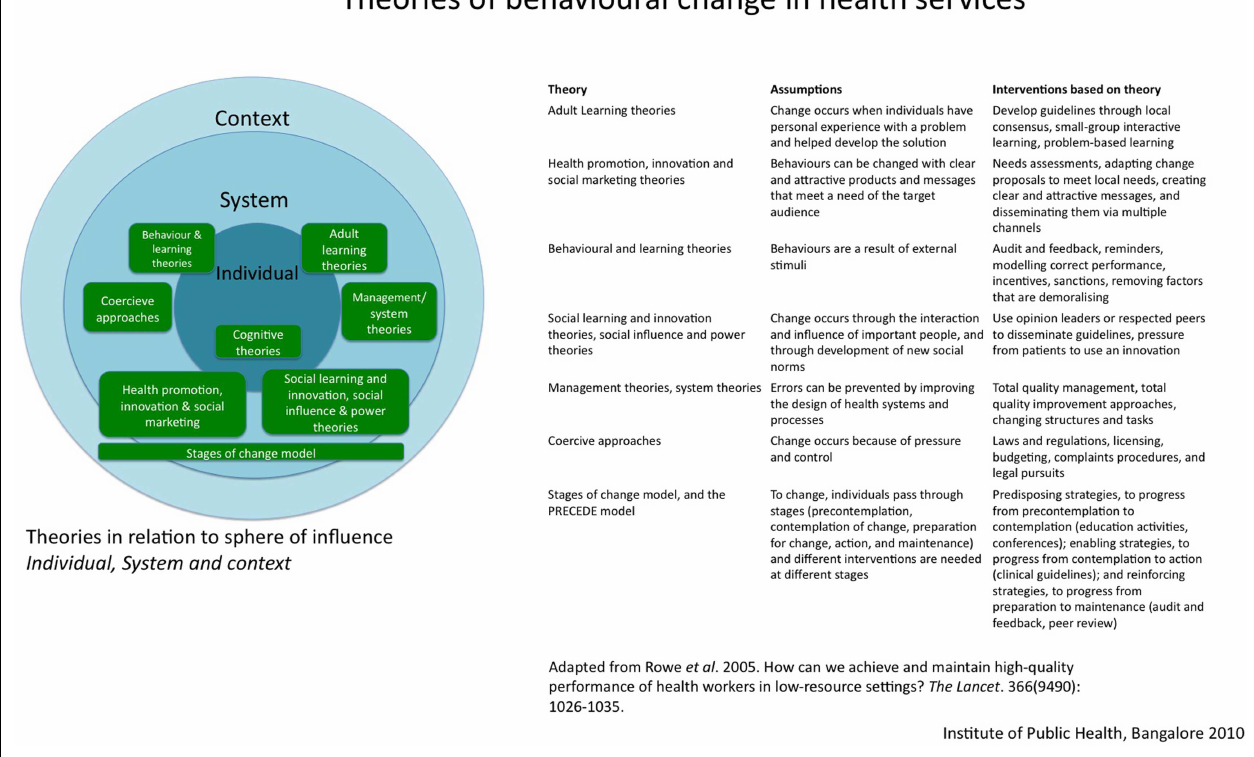
FIGURE 4 |Theories of behavioral change in health services in relation to their sphere of influence . Based on the review of theories that explain behavioral change in health services by Rowe et al.